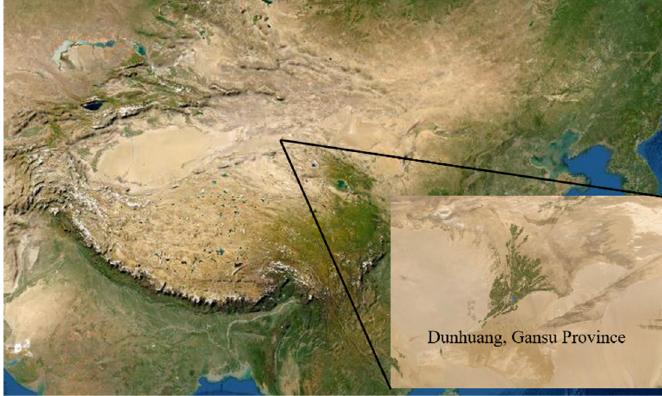
Figure 1. The experiment site at Dunhuang in Gansu province of Northwest China.